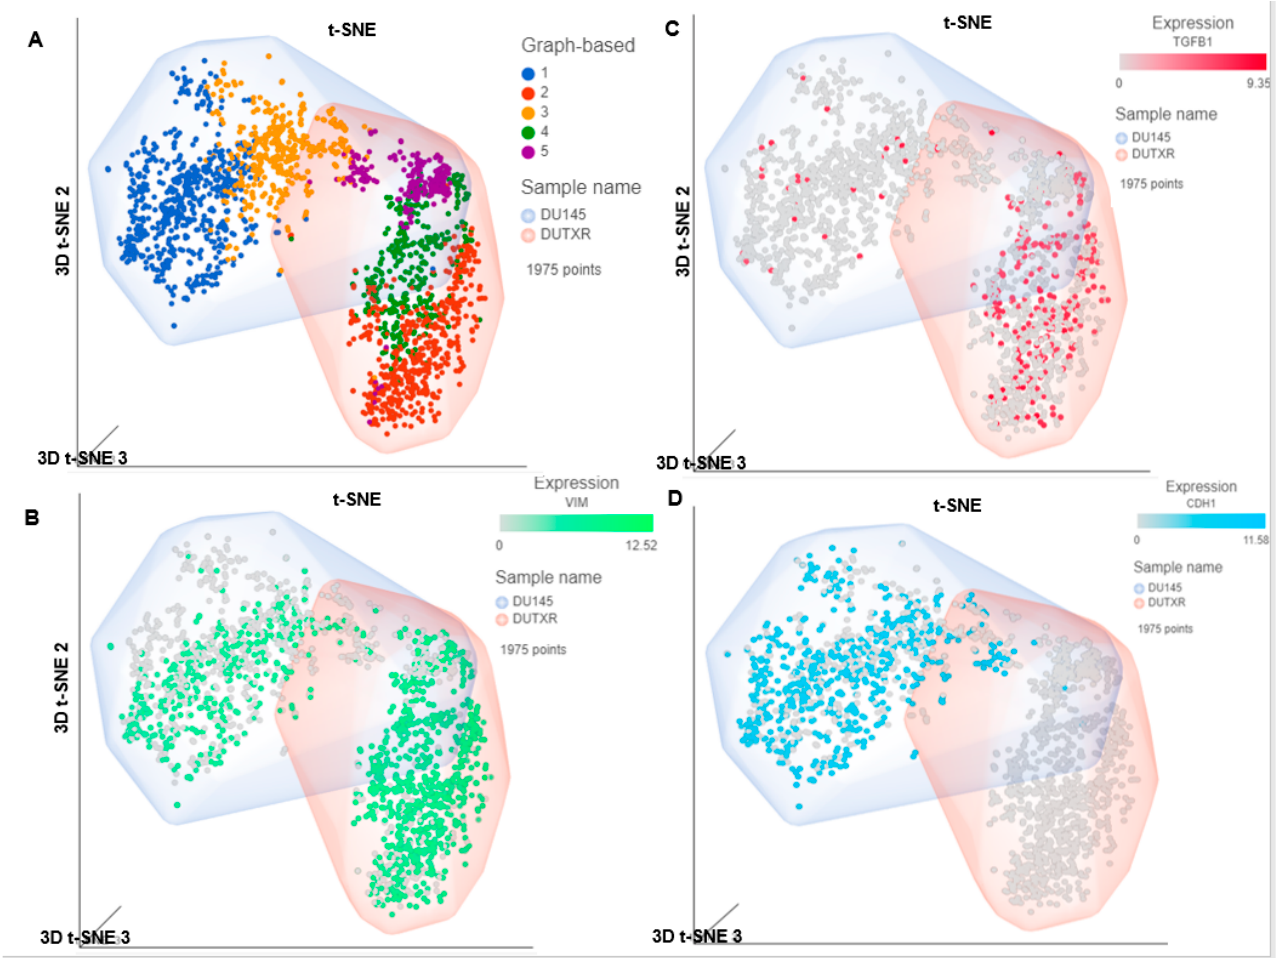
(CD44; Figure 2E,F) and drug resistance (CDK1, CXCL8; Figure 2G), indicating probable involvement of these genes in mCRPC development and progression [38].